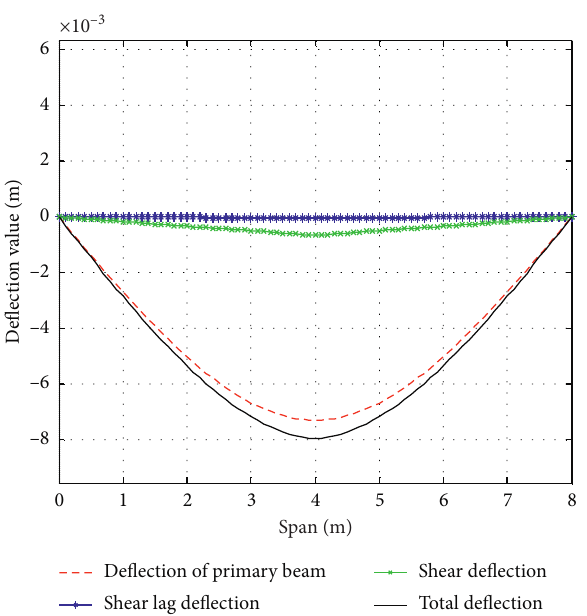
Figure 12: Concentrated load-deflection diagram of the single box and single cell simply supported composite box girder.